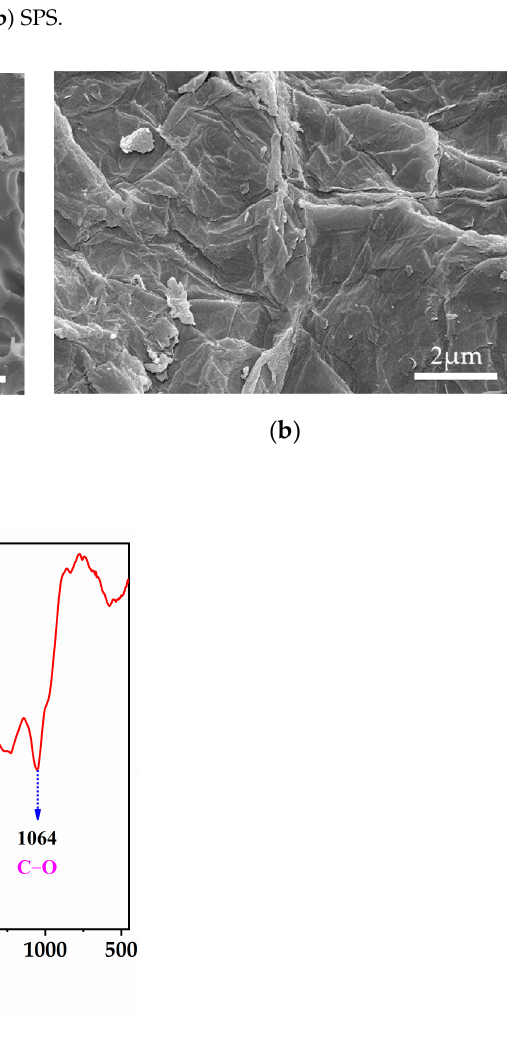
Figure 3. FTIR spectra of GO.